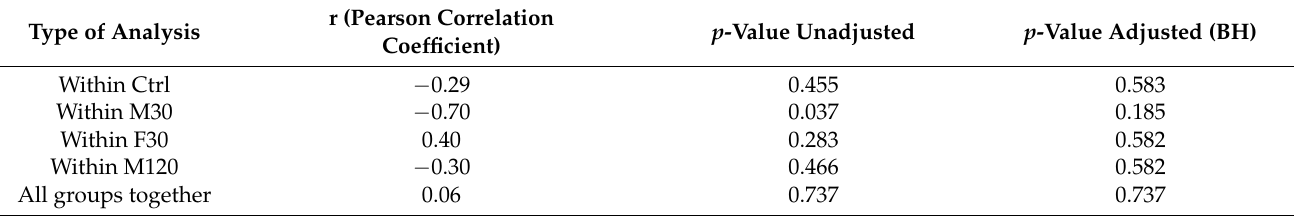
Table 3. Correlation between serum IL-6 [pg/mL] and EL [pg/mL] concentrations.